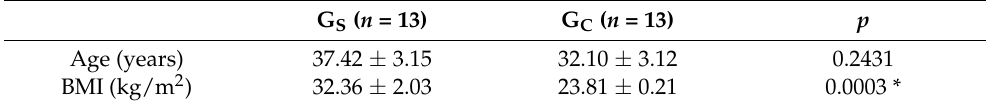
Table 1. Participant